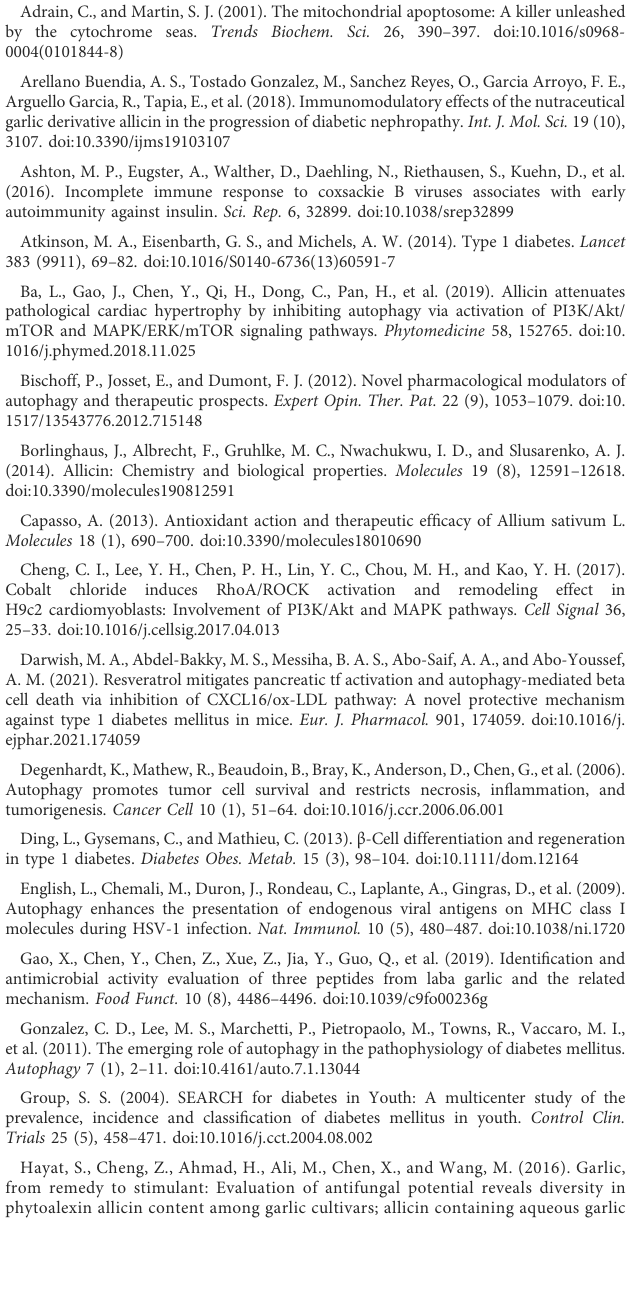
SUPPLEMENTARY FIGURE S1 The optimal working concentrations of STZ and Allicin on pancreatic β cell Min6 in vitro . (A) The effects of STZ on cell viability of pancreatic β cell Min6 in each group by CKK-8 assay ( n =5). (B) The effects of allicin on cell viability of pancreatic β cell Min6 in each group by CKK-8 assay ( n =5). Mean ± SD. *p < 0.05, ***p < .001 indicate signi fi cant differences. SUPPLEMENTARY FIGURE S2 Immuno fl uorescence staining for LC3 and P62 in pancreatic β cell Min6 in vitro . (A) Immuno fl uorescence staining for LC3 in pancreatic β cell Min6 from each group. The green staining designates LC3, and the blue staining shows the nucleus. (B) The bar graph represents the quanti fi cation of protein levels in each group ( n = 3). (C) Immuno fl uorescence staining for P62 in pancreatic β cell Min6 from each group. The green staining designates P62, and the blue staining shows the nucleus. (D) The bar graph represents the quanti fi cation of protein levels in each group ( n = 3). Mean ± SD. *p < .05, ***p < .001 indicate signi fi cant differences. Scale bars 100 μ